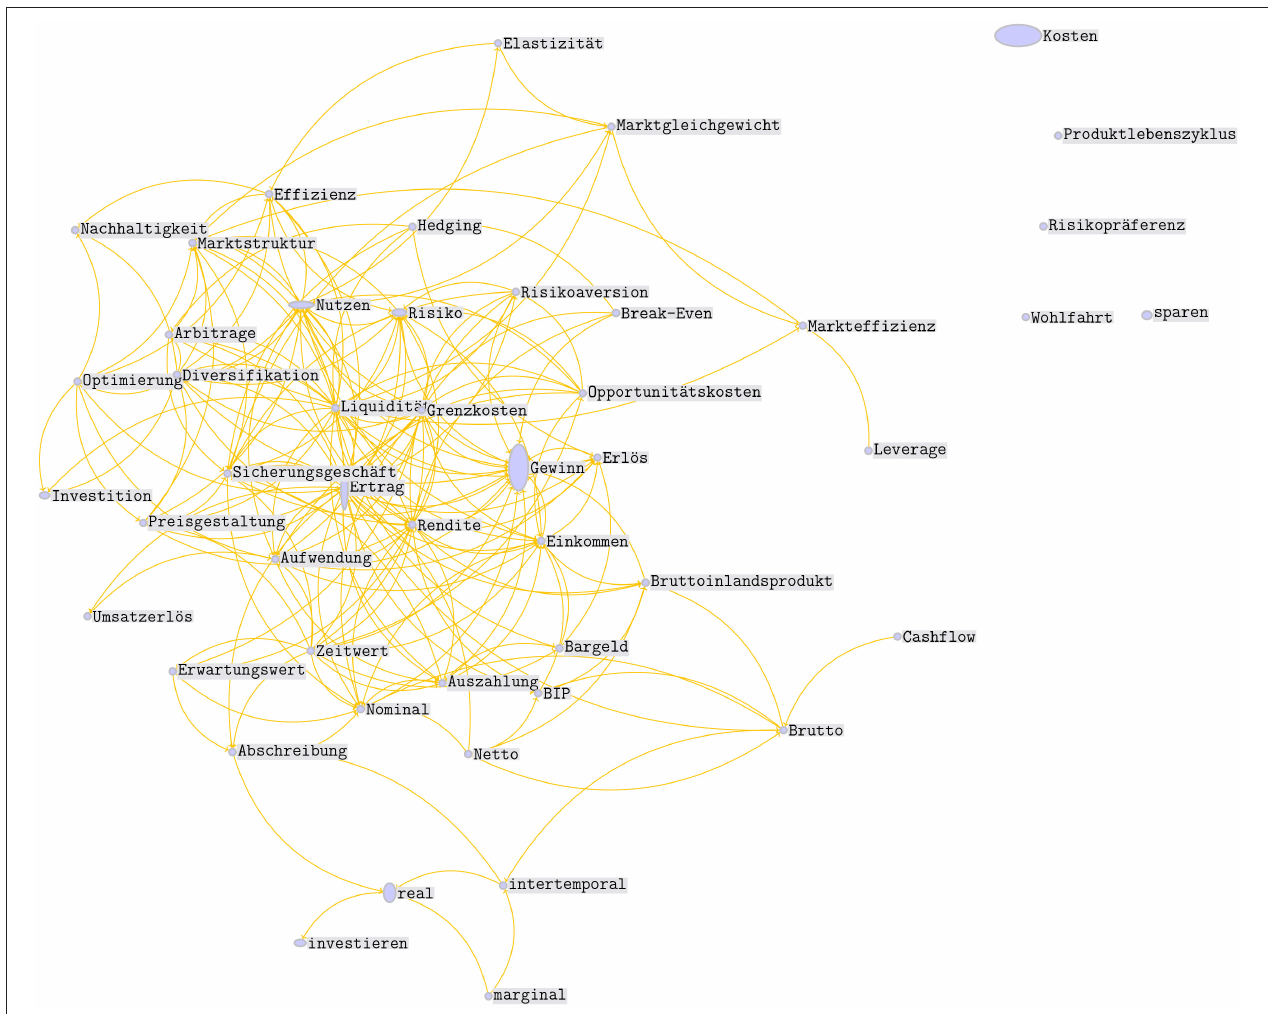
FIGURE 5 | Alpha-cut graph C ( T , α ) of the TCN based on SZ-All for α = 0.7. Vertex height: compounding-specificity; vertex width: sentence-specificity. For the vertices’ translations see Appendix A